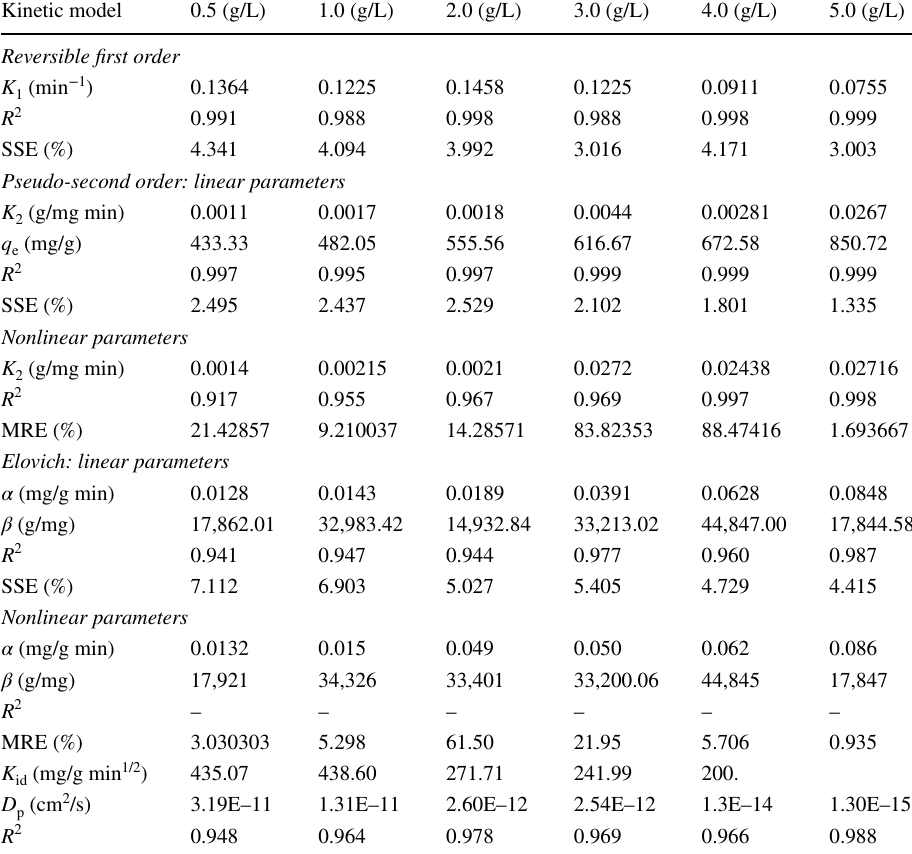
parameters at varying coagulant